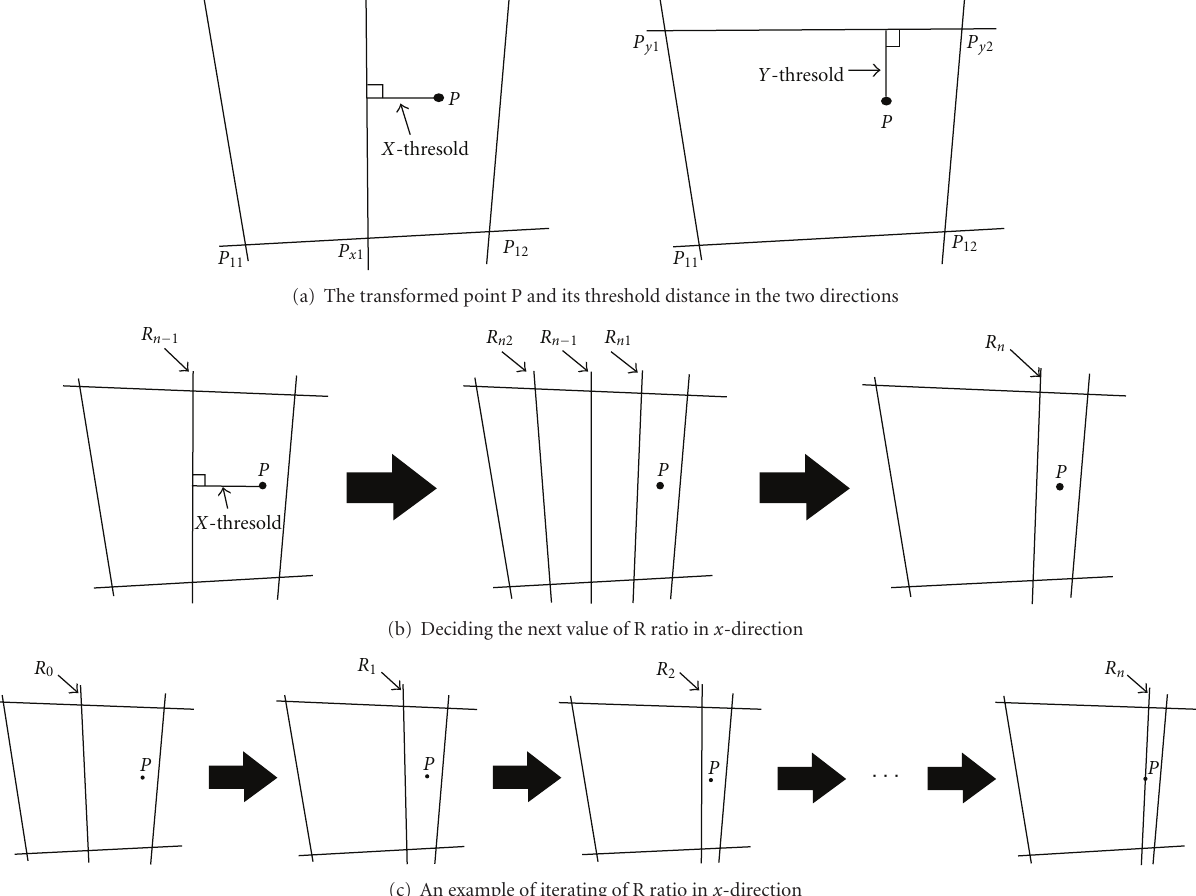
Figure 12: A sample illustration of transformation algorithm basics and steps.